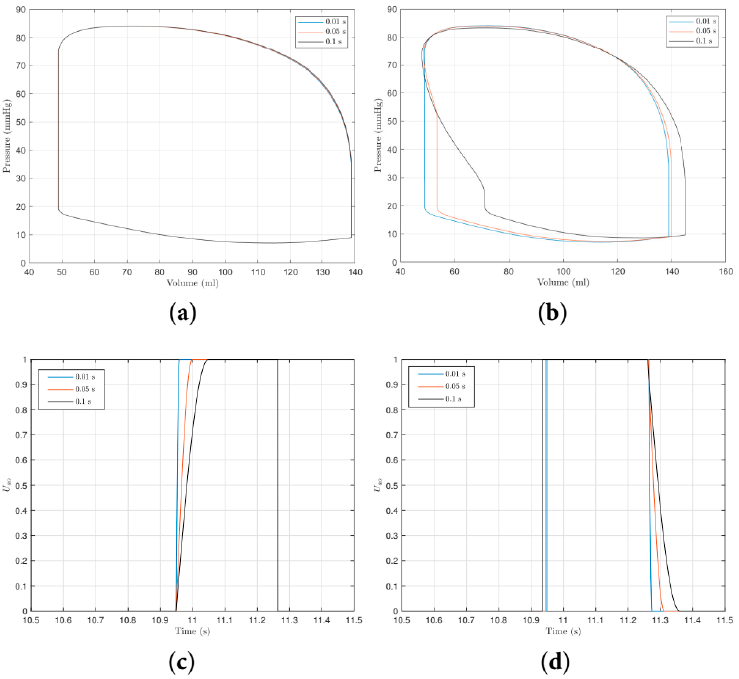
Figure 9. The effect of aortic valve opening and closing time. ( a , b ) show, respectively, the effect of aortic valve opening and closing time on the P-V loop, and ( c , d ) show traces of U ao for different opening and closing times (refer to Section 2.4 for an explanation of U ao ). ( a ) The effect of aortic valve opening time on the P-V loop. ( b ) The effect of aortic valve closing time on the P-V loop. ( c ) Time traces of U ao for different opening times. ( d ) Time traces of U ao for different closing